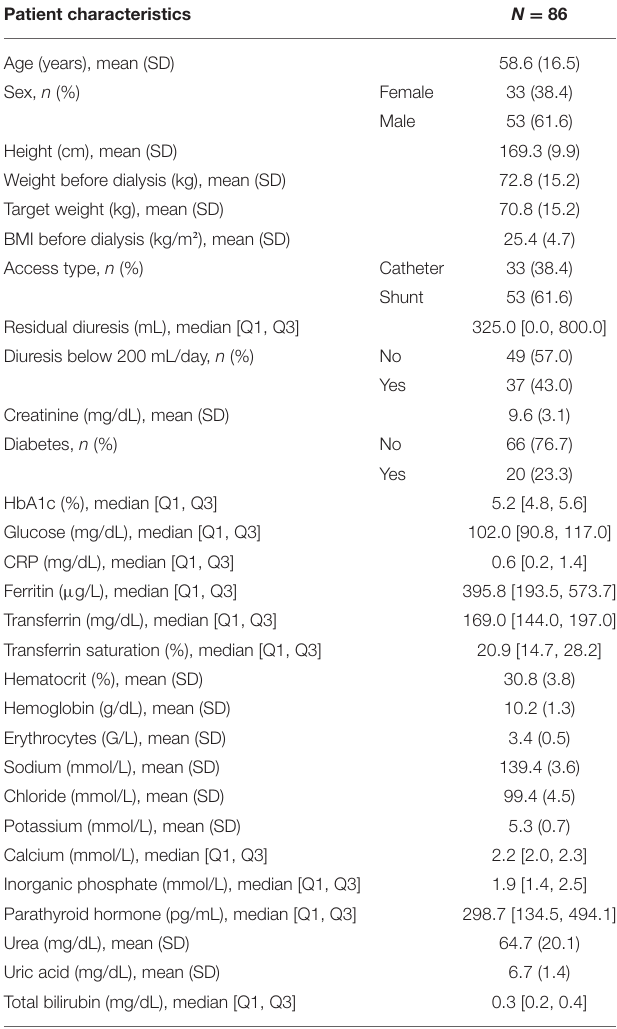
TABLE 1 | Patient characteristics (based on 86